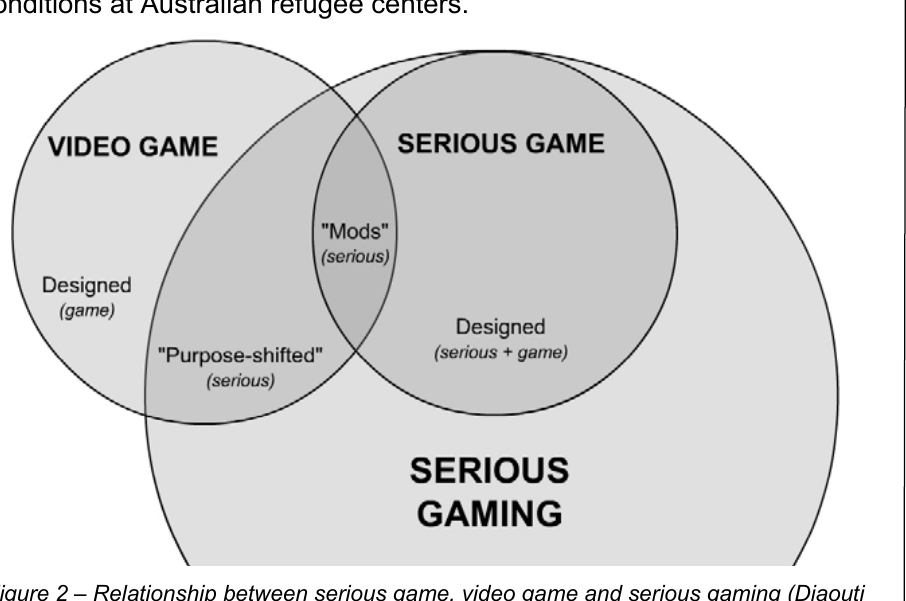
Figure 2 – Relationship between serious game, video game and serious gaming (Djaouti et al,